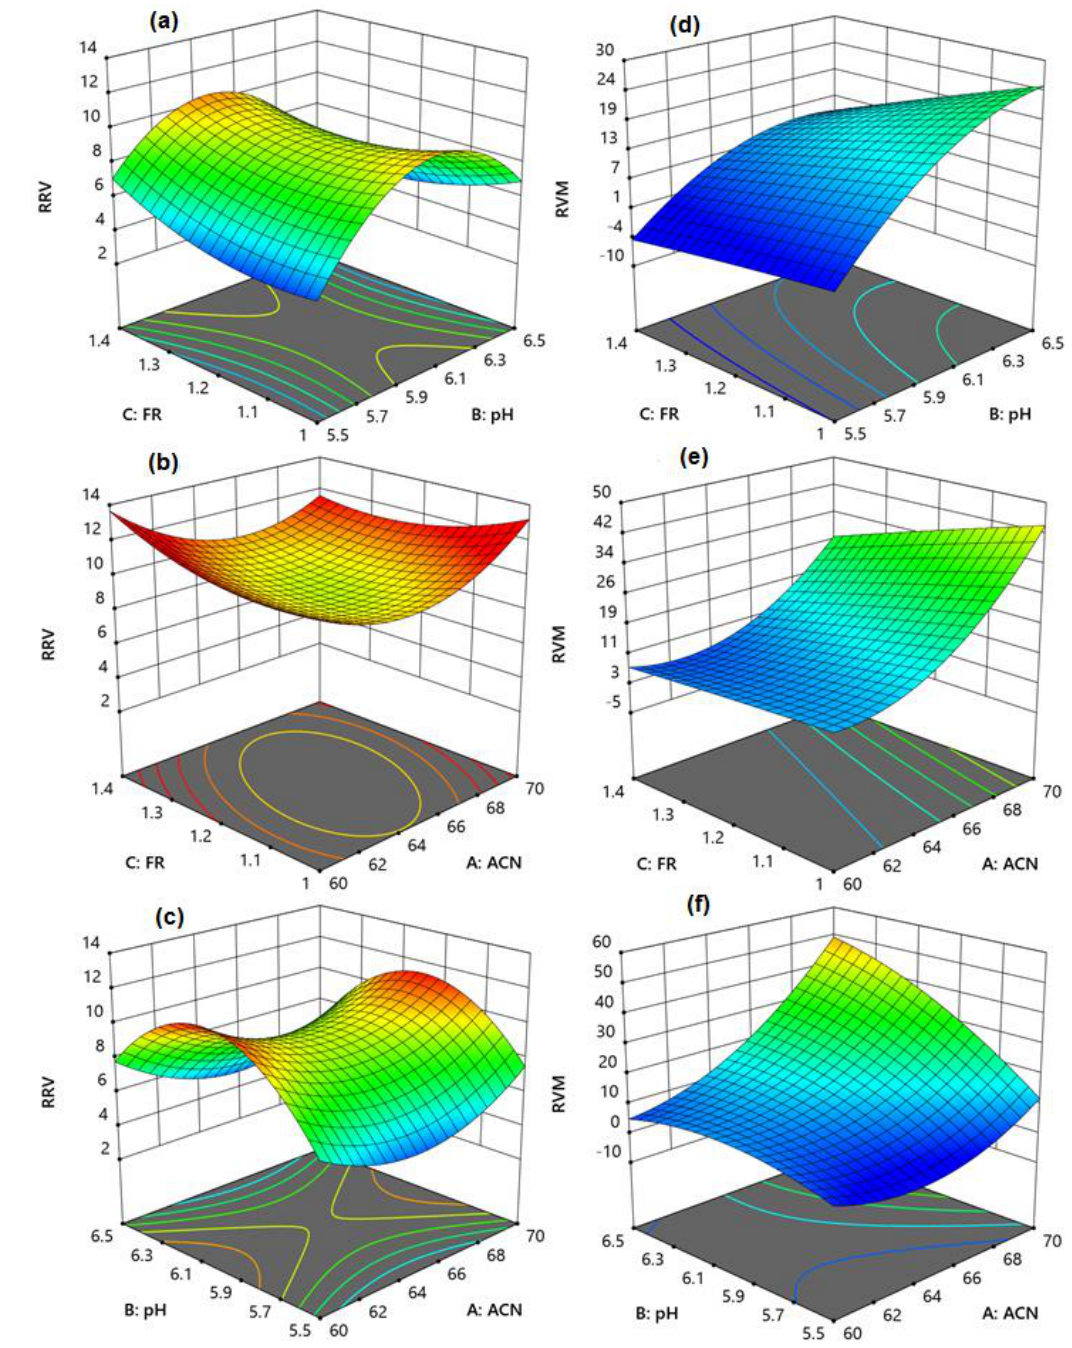
Figure 3. The 3D response surface models showing the effect of concentration of acetonitrile (A), pH of the mobile phase (B), and flow rate (C) on the resolutions of RE − VD ( a – c ) and VD − MF ( d – f ). Similarly, increasing the mobile phase pH and acetonitrile concentration increased the separation between VD and MF (Figure 3f), which is in agreement with the separation of hydrophilic analytes in HILIC conditions [55]. As a result, an intermediate pH of 6, acetonitrile concentration of 65% v / v , and flow rate of 1.2 mL/min were identified as excellent for improved resolution; however, the analysis duration was greater than 4